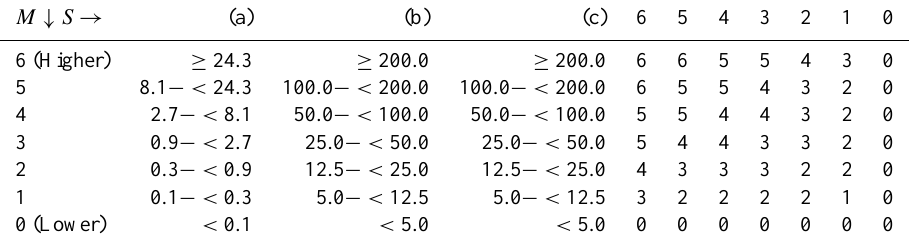
Table 3. Hazard indicator H : combination of S and M , with thresholds of (a) rock slide volume V rs (10 6 m 3 ), (b) area of hanging glacier A a (10 3 m 2 ) and (c) lake area A l (10 3 m 2 ).